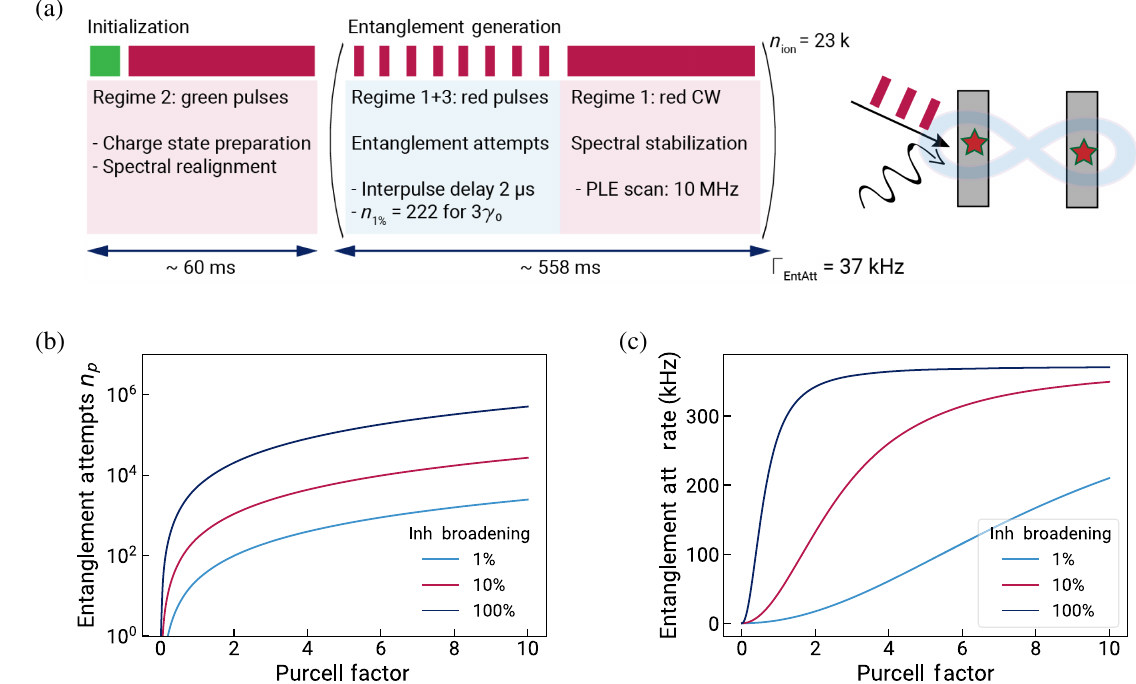
FIG. 5. Towards entanglement generation. (a) Entanglement protocol consisting of periods of system preparation (red) and entanglement generation (blue), with different periods assigned to the three excitation regimes discussed in this work. Here, we assume a threefold Purcell enhancement of the ZPL emission, and the protocol is bounded to the condition that only entanglement attempts (including optical spin-repump pulses) can be applied until the inhomogeneous linewidth is broadened by 1%. Then, a spectral stabilization protocol needs to be applied to tune the resonance back to the target frequency (5 ms). When the NV ionizes, the system is initialized by applying a green laser pulse. The protocol sequence for NV preparation involves charge-state initialization as well as spectral realignment. Inset: illustration of entanglement generation of two distant NV spin qubits embedded in nanostructures by applying coherent laser pulses (red) and microwave pulses (wavy line). (b) Entanglement attempts (number of π pulses) that can be applied until the total linewidth broadens by p percent due to spectral diffusion at a rate of 640 MHz = s as a function of Purcell enhancement, which can be engineered in different types of nanostructures. The estimated natural linewidth of γ 0 ¼ 14 . 2 (cid:2) 2 . 0 MHz considered in the model is increased by the corresponding Purcell factor. We model the inhomogeneous broadening of the linewidth with a Wiener process. Here, an inhomogeneous linewidth broadening of 100% corresponds to a broadening of twice the homogeneous linewidth. (c) Entanglement attempt rate using the protocol depicted in panel (a) as a function of the Purcell factor. For large Purcell factors, the entanglement attempt rate approaches a value of 370 kHz, which is given by the π -pulse separation of 2 μ s, the estimated ionization time, and the initialization [Fig. 5(c)]. Here, the maximum entanglement rate is limited by the entanglement attempt duration of 2 μ s adapted from Ref. [11] and system preparation time after ionization, which could both be technically improved.